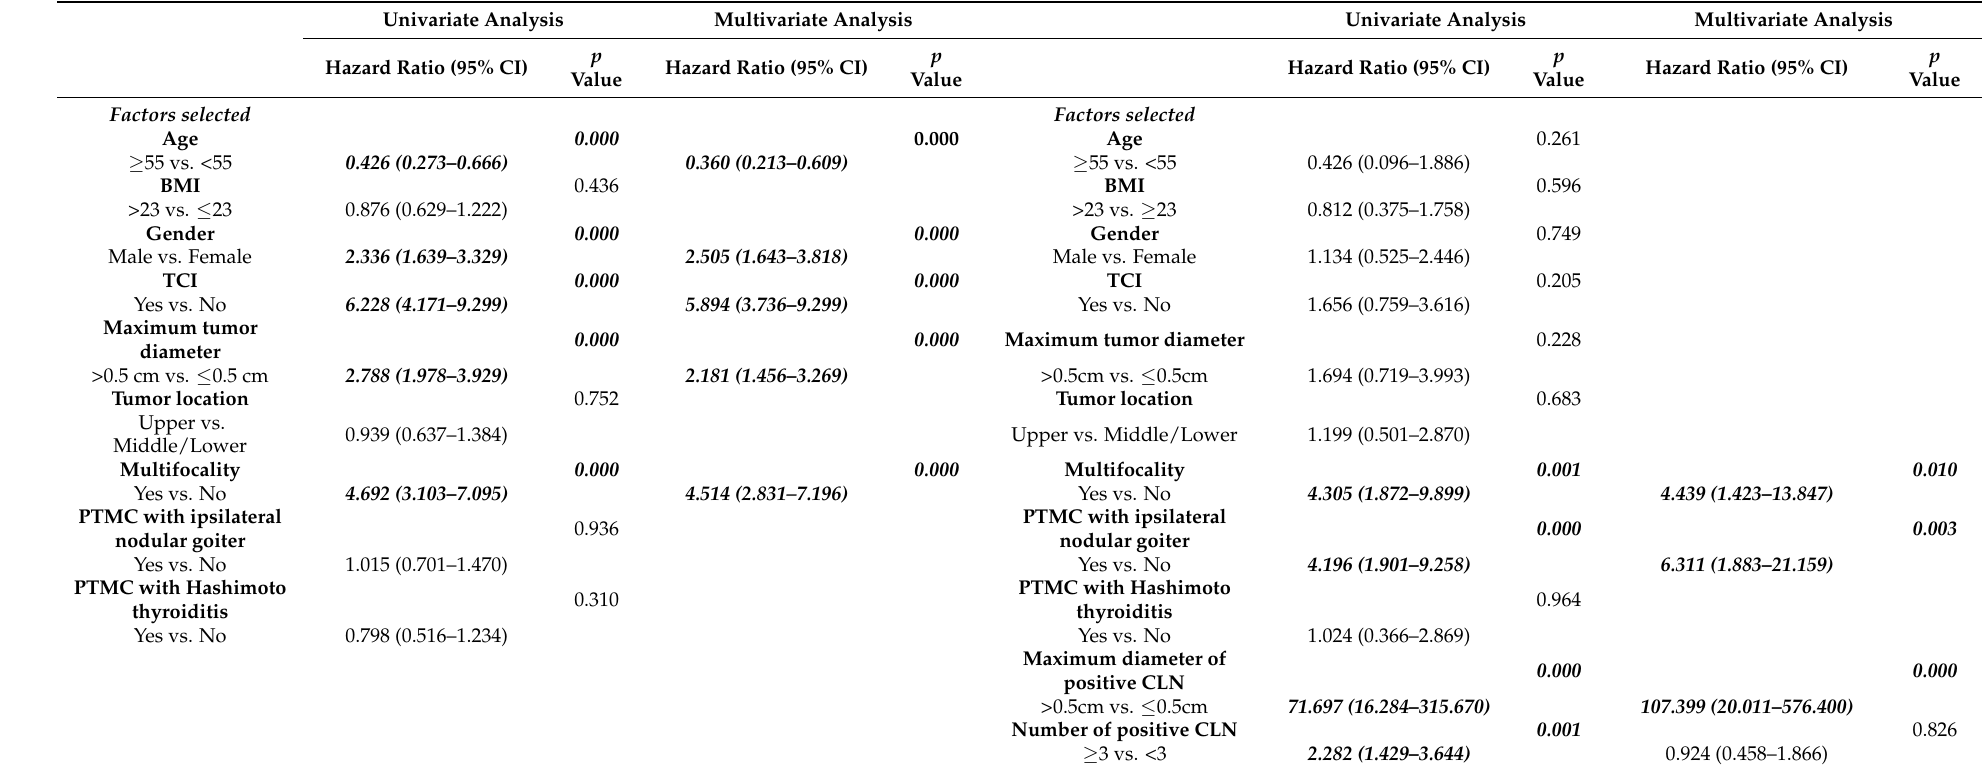
Table 3. Univariate and multivariate analyses for PTMC patients with unilateral disease. Univariate Analysis Multivariate Analysis Univariate Analysis Multivariate